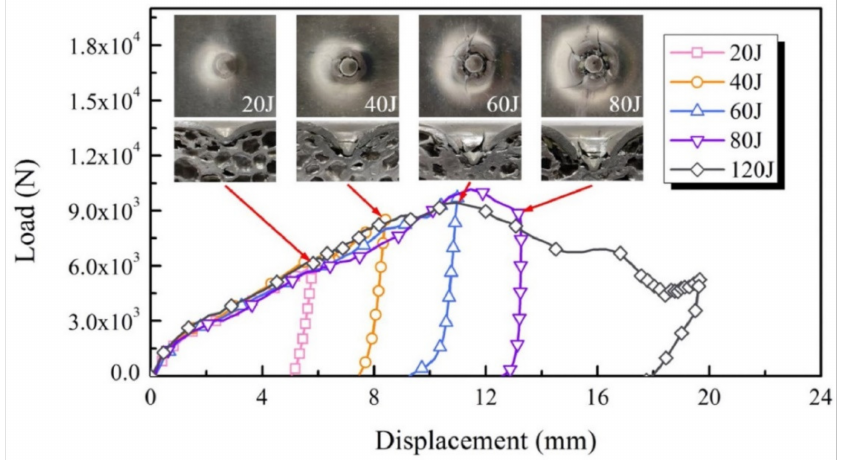
Figure 23. Impacting responses and the corresponding failure process of the sandwich panels using the conical impactor with different impacting energies